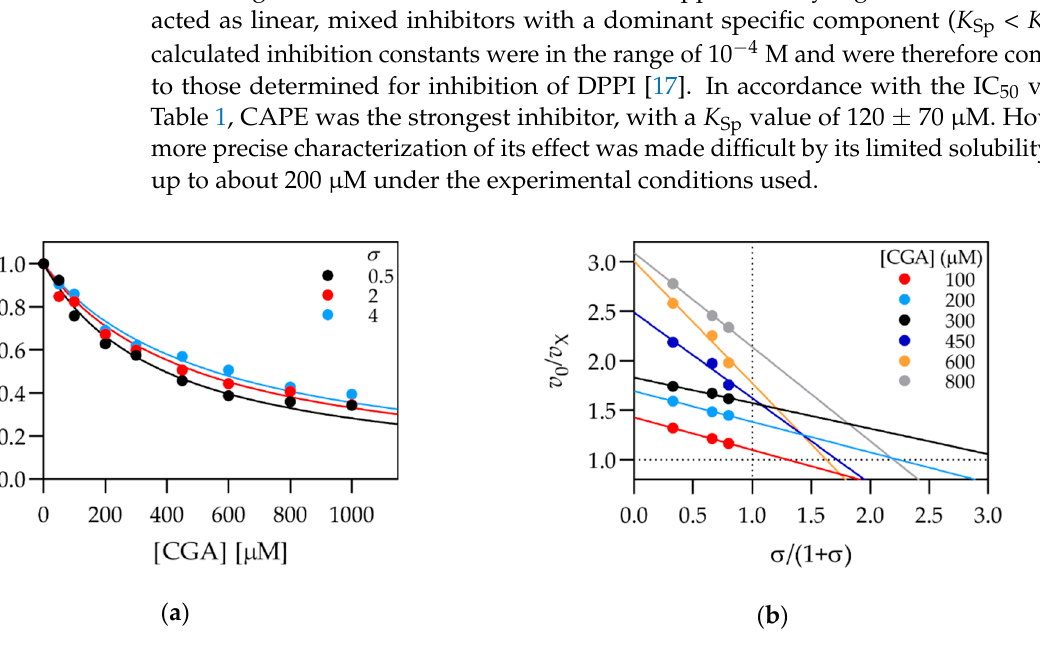
Figure 2. Kinetic characterization of the inhibition of cathepsin L by chlorogenic acid (CGA). ( a ) Titration curves produced at three different substrate concentrations. Decreasing inhibitor efficiency with increasing substrate concentration indicates predominantly specific inhibition; ( b ) replot of the data in panel ( a ) in the form of the specific velocity plot. Straight lines (corresponding to individual inhibitor concentrations) intersect the y = 1 axis at x values larger than 1, indicating a mixed, predominantly specific mechanism. σ equals [S]/ K m . Experiments were performed at 25 °C, in 50 mM Na-acetate buffer pH 5.5, with 1 mM EDTA and 2.5 mM DTT.